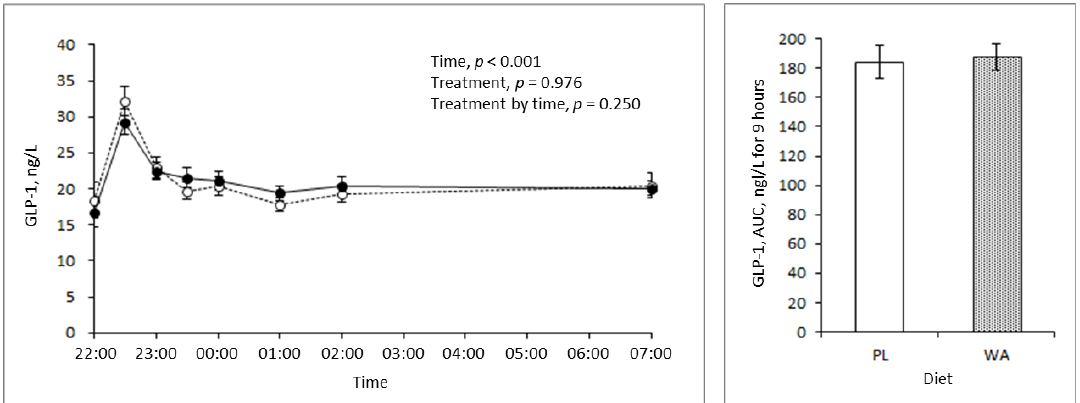
Figure 5. Changes in the blood active glucagon-like peptide-1 (GLP-1) level during the night between the PL (broken line, n = 20) and the WA treatments (solid line, n = 20). ( Left ) Changes in the blood GLP-1 response. ( Right ) The AUC of the blood GLP-1 level for 9 h from 22:00 hour to 7:00 hour. Data are the mean ± standard